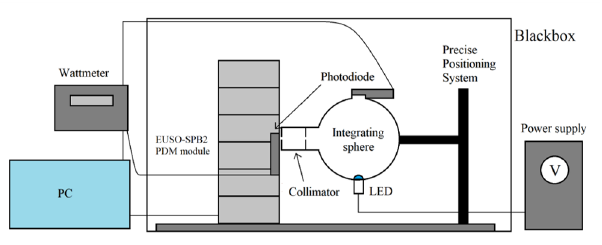
Figure 2. Scheme of the calibration process, with a collimator attached to the integrating sphere for single pixel illumination.